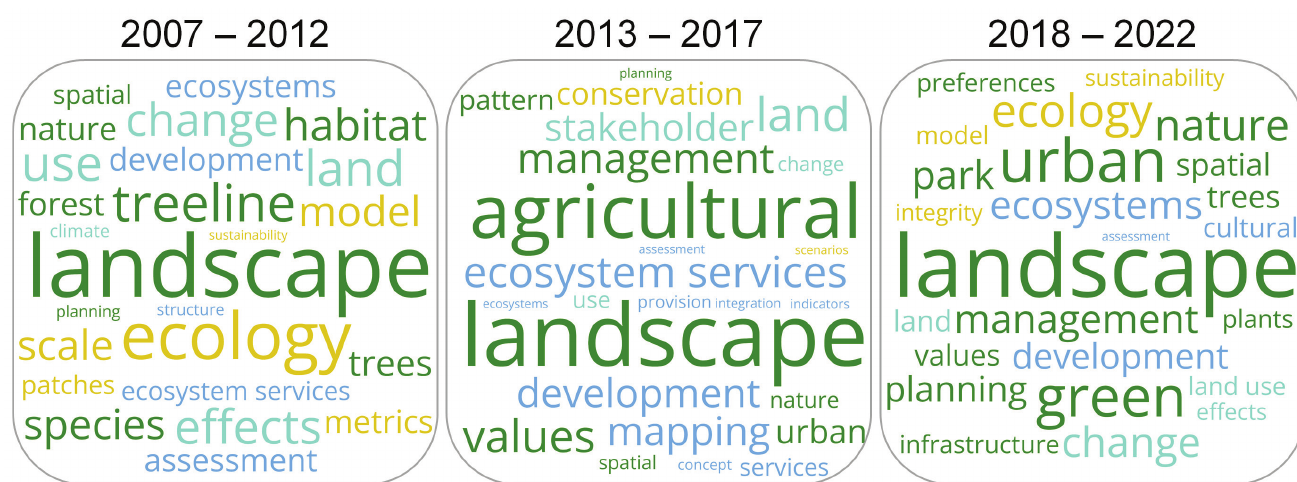
Figure 4. Word clouds of the most used 100 terms in titles, abstracts and keywords of all articles published during the three indicated